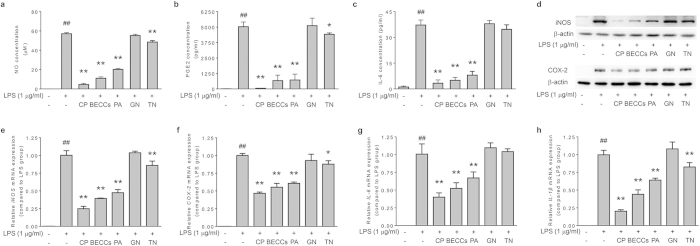
Chemical family classification-based screening of anti-inflammatory compounds from CP.Cells were pretreated with tested samples (at a corresponding concentration in 0.4 mg/ml CP) for 1 h, followed by treatment with LPS (1 μg/ml) and incubation for indicated time. Concentration of (a) NO, (b) PGE2 and (c) IL-6 in the supernatant. (d) Protein expression levels of iNOS and COX-2. β-actin was used as an internal loading control. The expression levels of mRNA for (e) iNOS, (f) COX-2, (g) IL-6 and (h) IL-1β were analyzed by quantitative real-time PCR. GAPDH served as internal control for normalization of mRNA expression. Data are presented as mean ± SD of three independent experiments performed in duplicate. ##p < 0.01 versus control group; *p < 0.05, **p < 0.01 versus LPS group (one-way ANOVA, Dunnett test). CP: Cardiotonic Pill; PA: combination of 10 phenolic acids; GN: combination of 4 ginsenosides; TN: combination of 4 tanshinones; BECCs: bioactive equivalent combinatorial components (combination of PA, GN and TN).